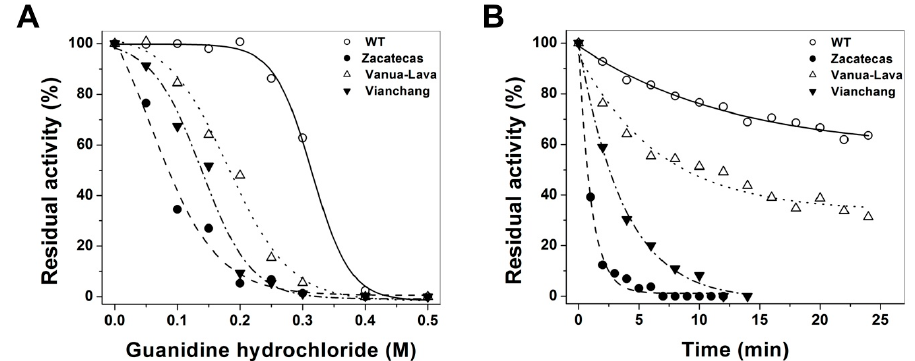
Figure 5. Stability of glucose-6-phosphate dehydrogenases (G6PDs) incubated with different concentrations of Gdn-HCl and inactivation assays. ( A ) Effects of Gdn-HCl on the activity of WT G6PD and the G6PD Zacatecas, Vanua-Lava and Viangchan mutants. All the enzymes were incubated at 0.2 mg/mL in 50 mM phosphate buffer pH 7.35 in the presence of the indicated concentrations of Gdn-HCl for 2 h at 37 °C; ( B ) Inactivation of WT G6PD and the mutants by 0.25 M at 37 °C. At the indicated times, aliquots were withdrawn from the samples and assayed for residual activity. In both assays, residual activity was expressed as a percentage of the activity for the same sample measured at 25 °C without Gdn-HCl and all enzymes were prepared and diluted immediately before used. Both assays were performed in duplicate; standard errors were less than 5%.